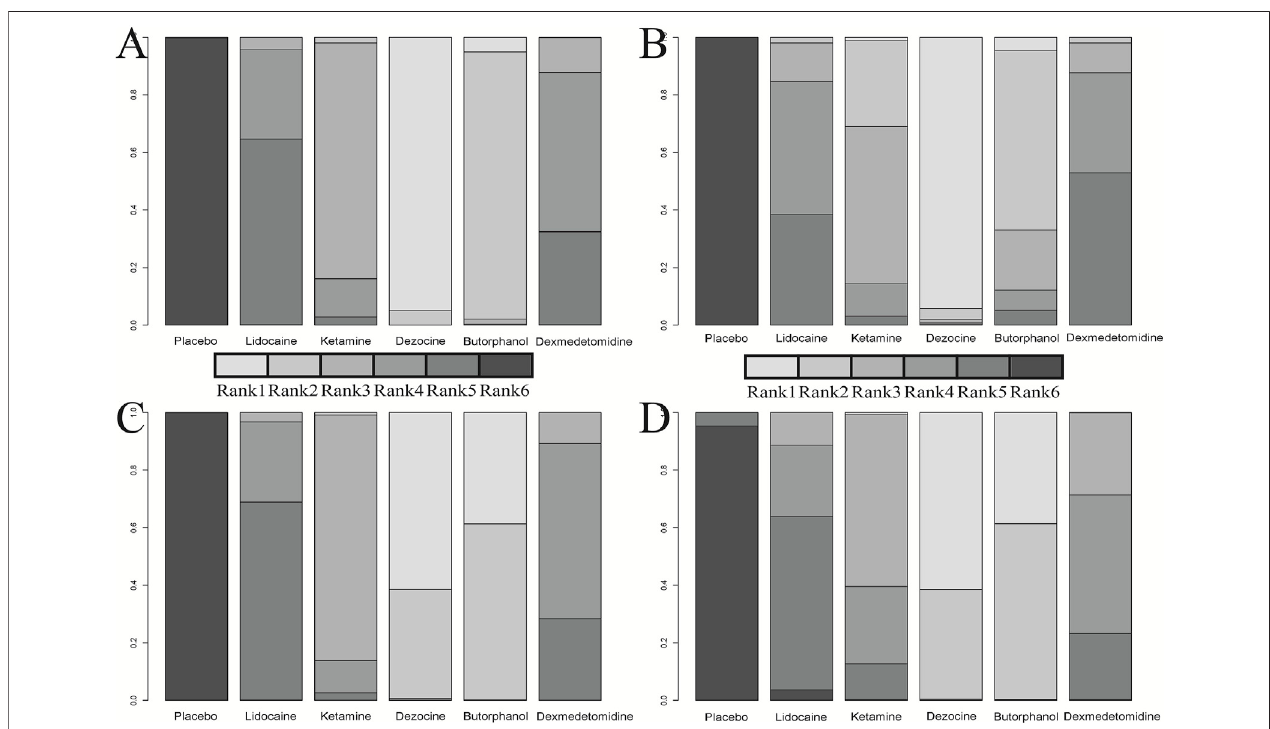
FIGURE 6 | Cumulative rank plot for four clinical outcomes. (A) Incidence of OIC; (B) Mild severity of OIC; (C) Moderate severity of OIC; and (D) Severe severity of OIC.